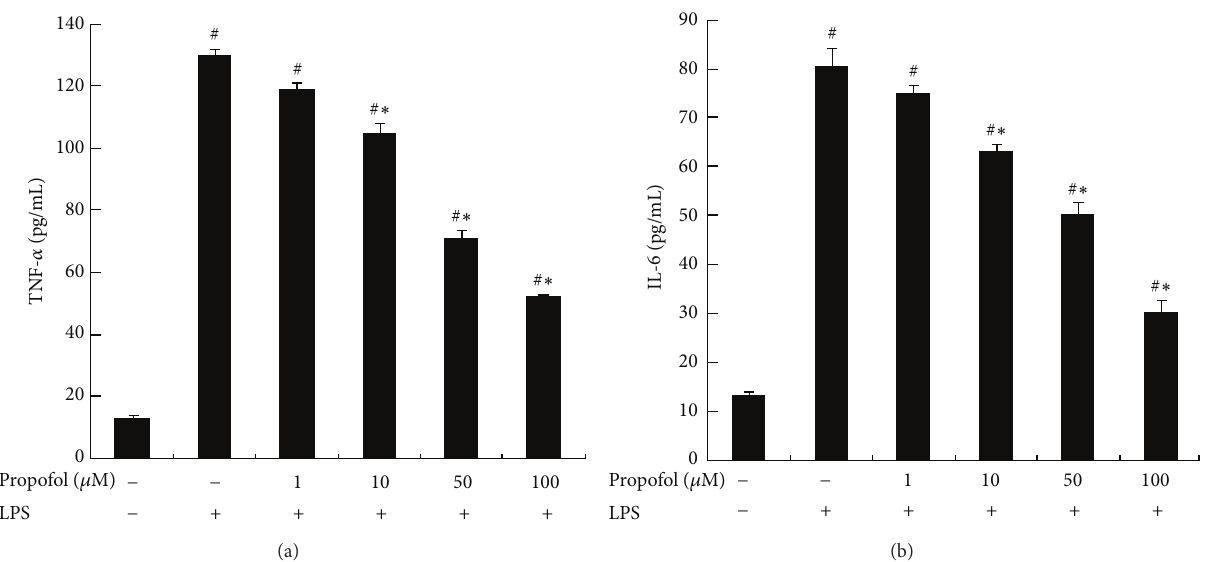
Figure 1: Effect of propofol on LPS-induced TNF- 𝛼 and IL-6 secretion. Macrophages were pretreated with dimethyl sulfoxide (DMSO) or 1 𝜇 M, 10 𝜇 M, 50 𝜇 M, and 100 𝜇 M propofol for 40min and stimulated with 100ng/mL LPS for 8h. The concentrations of TNF- 𝛼 and IL-6 in culture supernatants were measured by ELISA. Each value represents the means ± SD for 𝑛 = 4 . # and ∗ indicate statistically significant differences ( 𝑃 < 0.05 ) between propofol and LPS treated and LPS only treated groups, respectively.